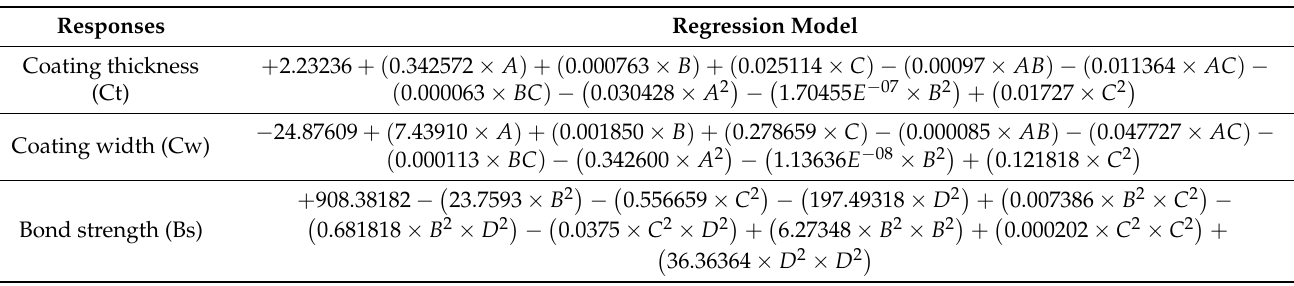
Table 8. Regression model equation for the